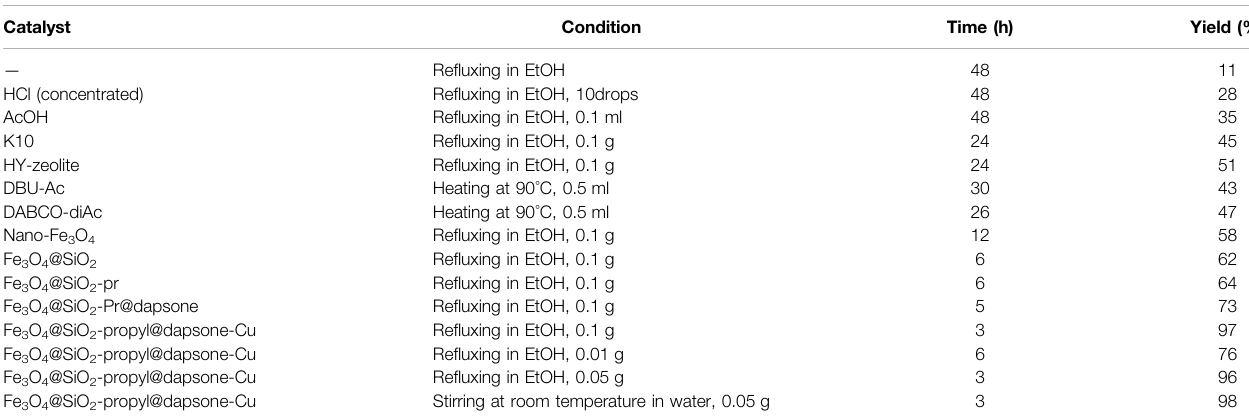
synthesized MNPs. The zeta potential value of dispersed